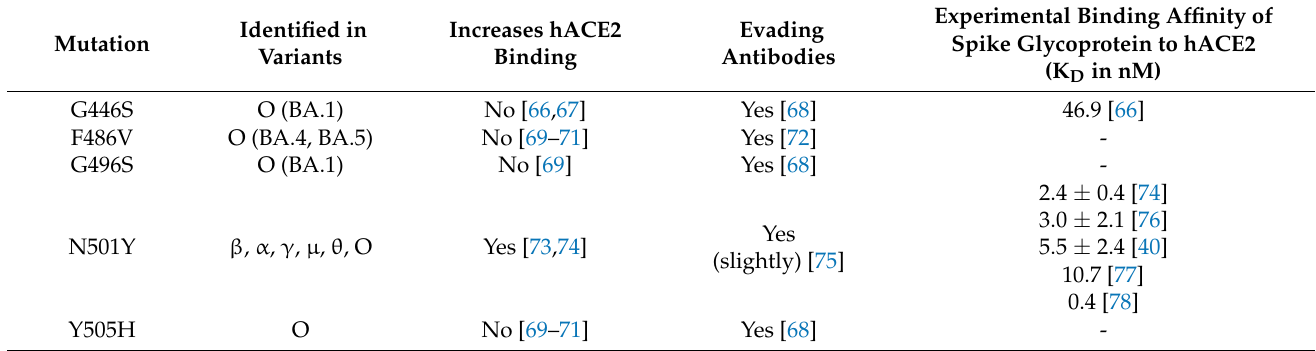
Table 1. Selected mutations for the